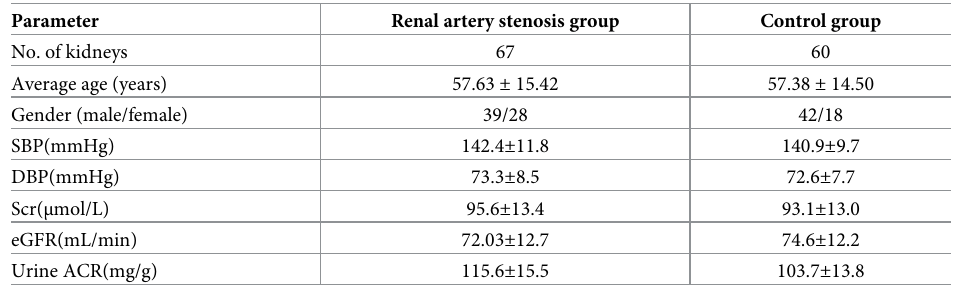
Table 2. Comparison of demographics between study group participants.